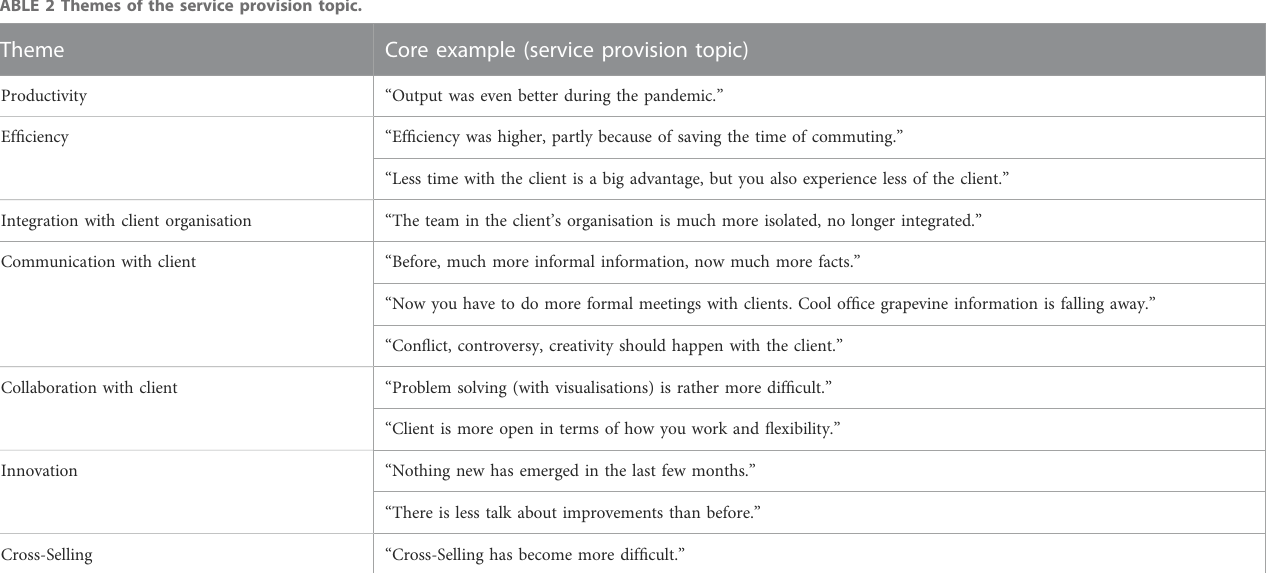
TABLE 2 Themes of the service provision